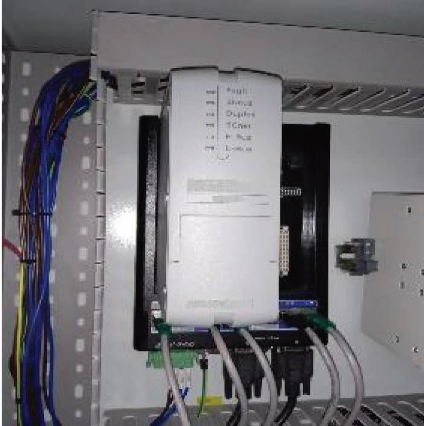
Figure 8: Te embedded computer in the semiphysical NPP